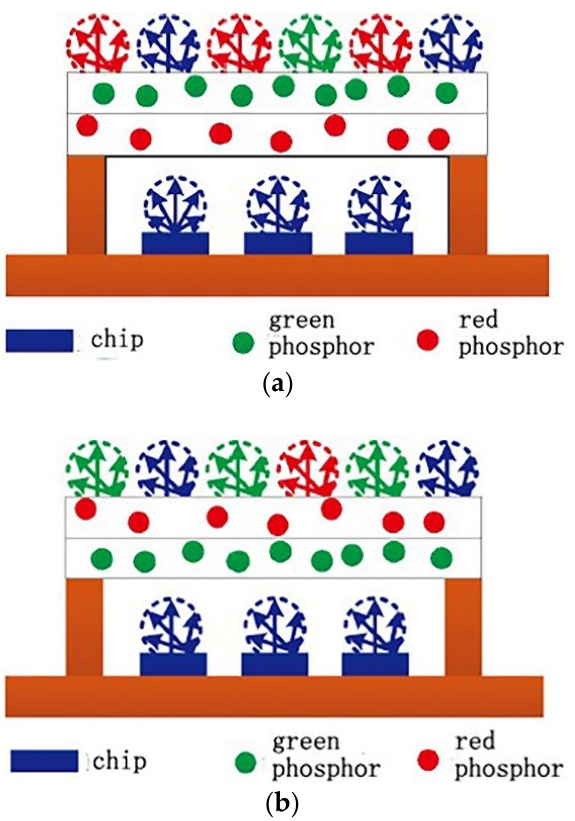
Figure 8. ( a ) Blue-red-green (B-R-G) and ( b ) blue-green-red (B-G-R) film packages [67] .